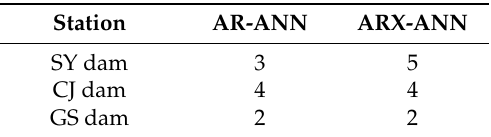
Figure 8. Correlation coefficients ( r ) and root mean square error (RMSE) of the AR-ANN and ARX-ANN models according to the number of nodes in the validation period for the SY, CJ, and GS dams. The blue line is the r -value in the validation period and the red line is the RMSE in the validation period. Table 6. The optimal number of the hidden nodes of the AR-ANN and ARX-ANN models for the three